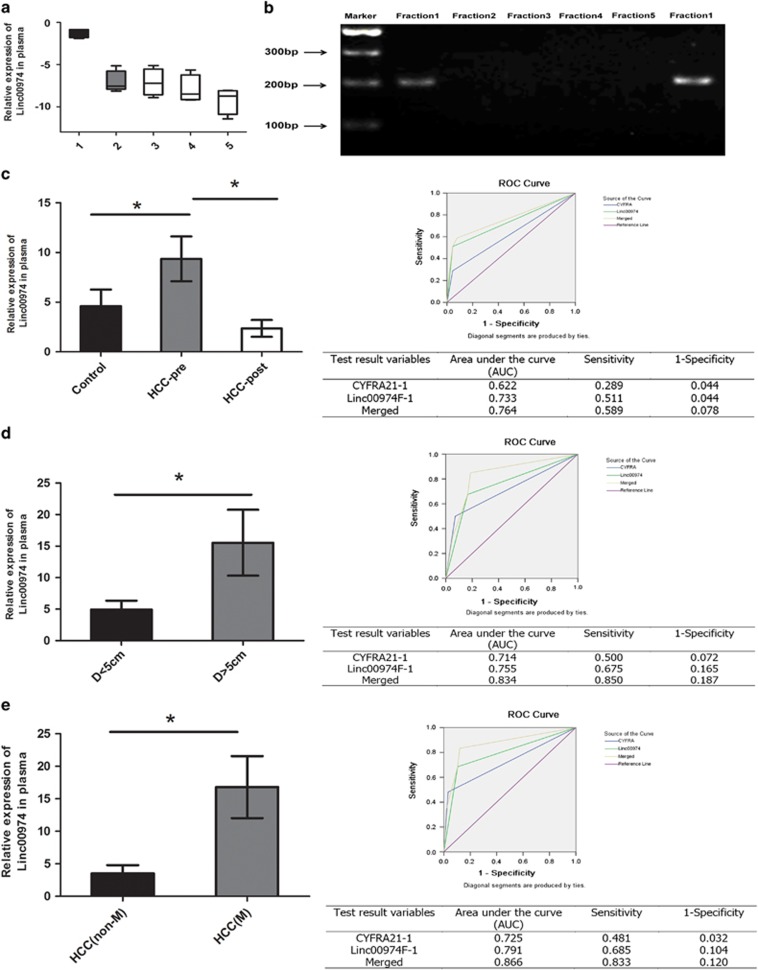
Linc00974 might act as a biomarker in HCC patients. (a) Five primers spaced every 500-bp across the complete Linc00974 transcript were designed. qRT-PCR was used to detect the expression of all fractions in HCC plasma samples. The results indicated that fraction1 was the highest expressed in plasma. (b) The PCR product was applied for agarose electrophoresis for validation. (c) Expression of Linc00974 was detected in patients in whom plasma was obtained from both preoperative and postoperative samples, by comparing with patients free of tumor. ROC curve analysis of merged Linc00974F-1 and CYFRA21-1 was employed to detect the diagnostic efficiency of HCC. Sensitivity and specificity are listed in the left of the curve. (d and e) Expression of Linc00974 was detected in subgroups grouped by tumor diameter (cutoff: 5 cm) and metastasis. Further ROC curve analysis was used for merged Linc00974F-1 and CYFRA21-1 to predict tumor growth and metastasis in HCC. All experiments are presented as the mean±S.E.M. *Indicates significant difference compared with the control group (P<0.05)